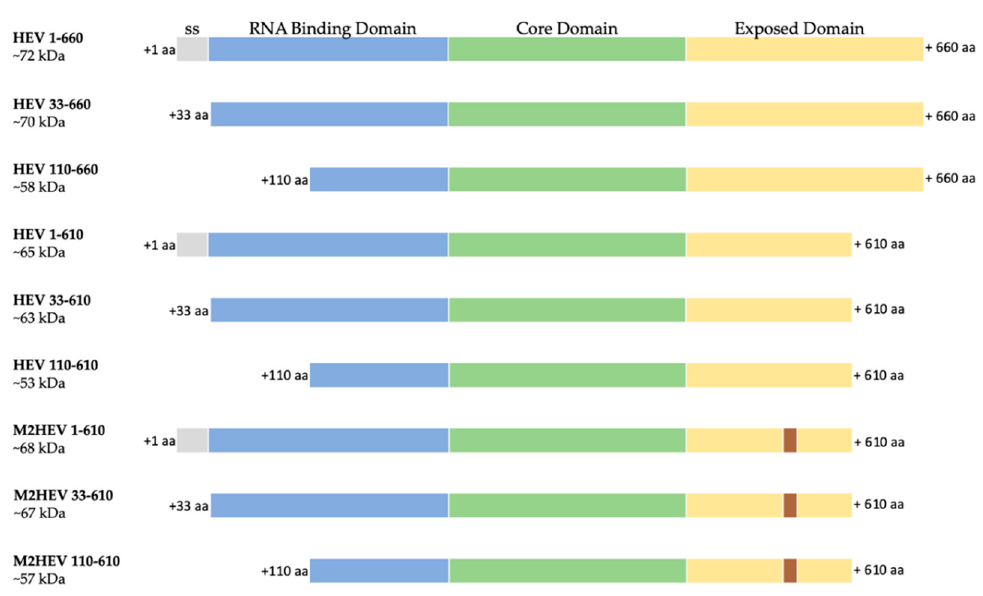
Figure 1. Schematic representation of the nine HEV constructs; ss–signal sequence (grey), RNA binding domain (blue), Core domain (green) and Exposed domain (yellow) containing the M2e peptide (brown) are presented as bars with di ff erent colors; 1. HEV 1–660 (full length construct); 2. HEV 33–660 (without leader sequences); 3. HEV 110–660 (N-terminal truncated); 4. HEV 1–610 (C-terminal truncated); 5. HEV 33–610 (C-terminal truncated without leader); 6. HEV 110–610 (N- and C-terminal truncated); 7. M2 HEV 1–610 (chimeric construct based on the C-terminal truncated construct); 8. M2 HEV 33–610 (chimeric construct based on the C-terminal truncated construct without leader); 9. M2 HEV 110–610 (chimeric construct based on the N- and C-terminal truncated construct).